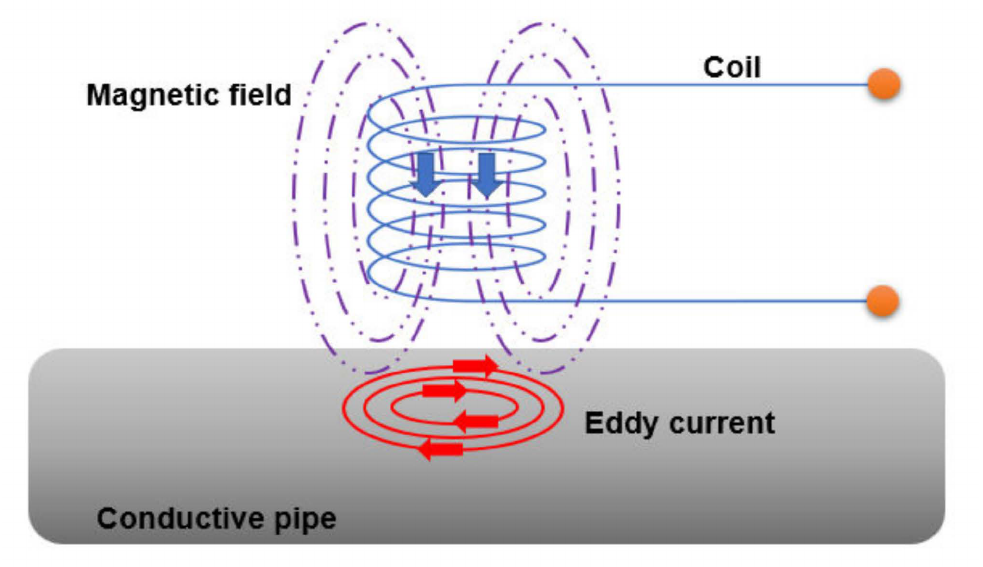
Figure 9. Schematic of eddy current used to inspect the occurrence of corrosion under insulation on a conductive steel